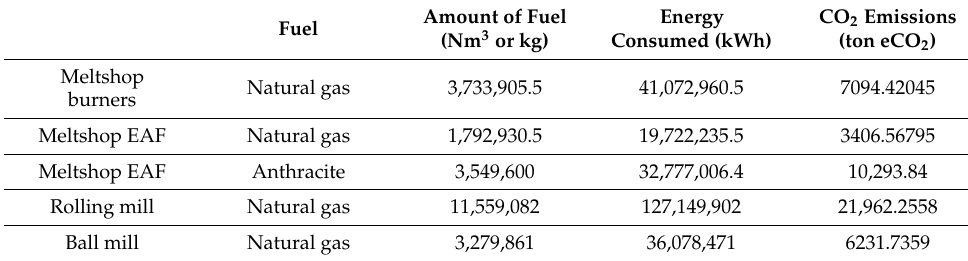
Table 3. Values for the digital tool solution cases.